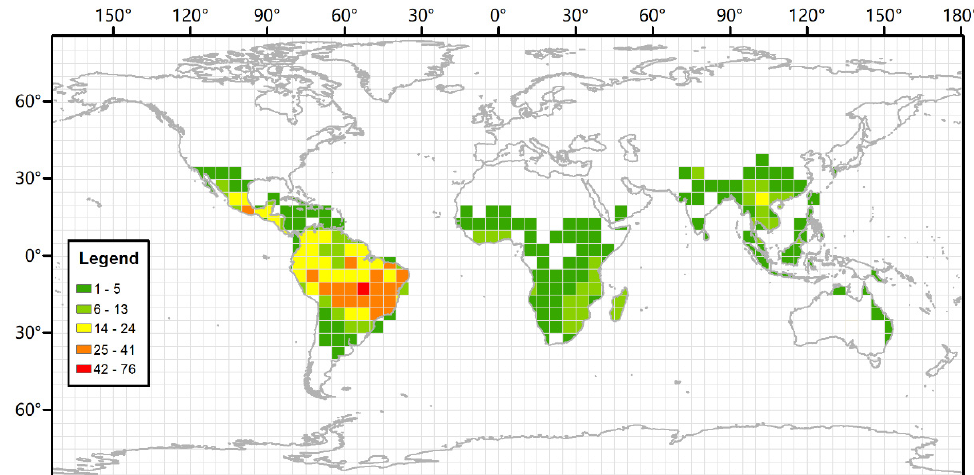
Figure 1. Extant distribution of Bauhinia . Different colors in the map indicate the number of species in each grid square. Extant occurrence data of Bauhinia are from the Global Biodiversity Information Facility (GBIF).